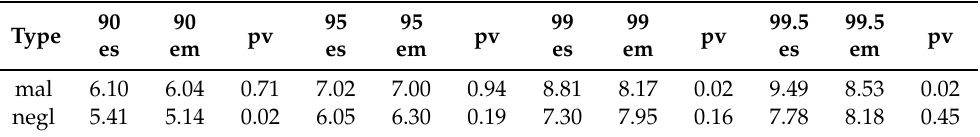
Table 5. Risk measurement results: estimated (es) and empirical (em) values of the log of breached records for the two considered categories, malicious (mal) and negligent (negl), along with the p values (pv) of their